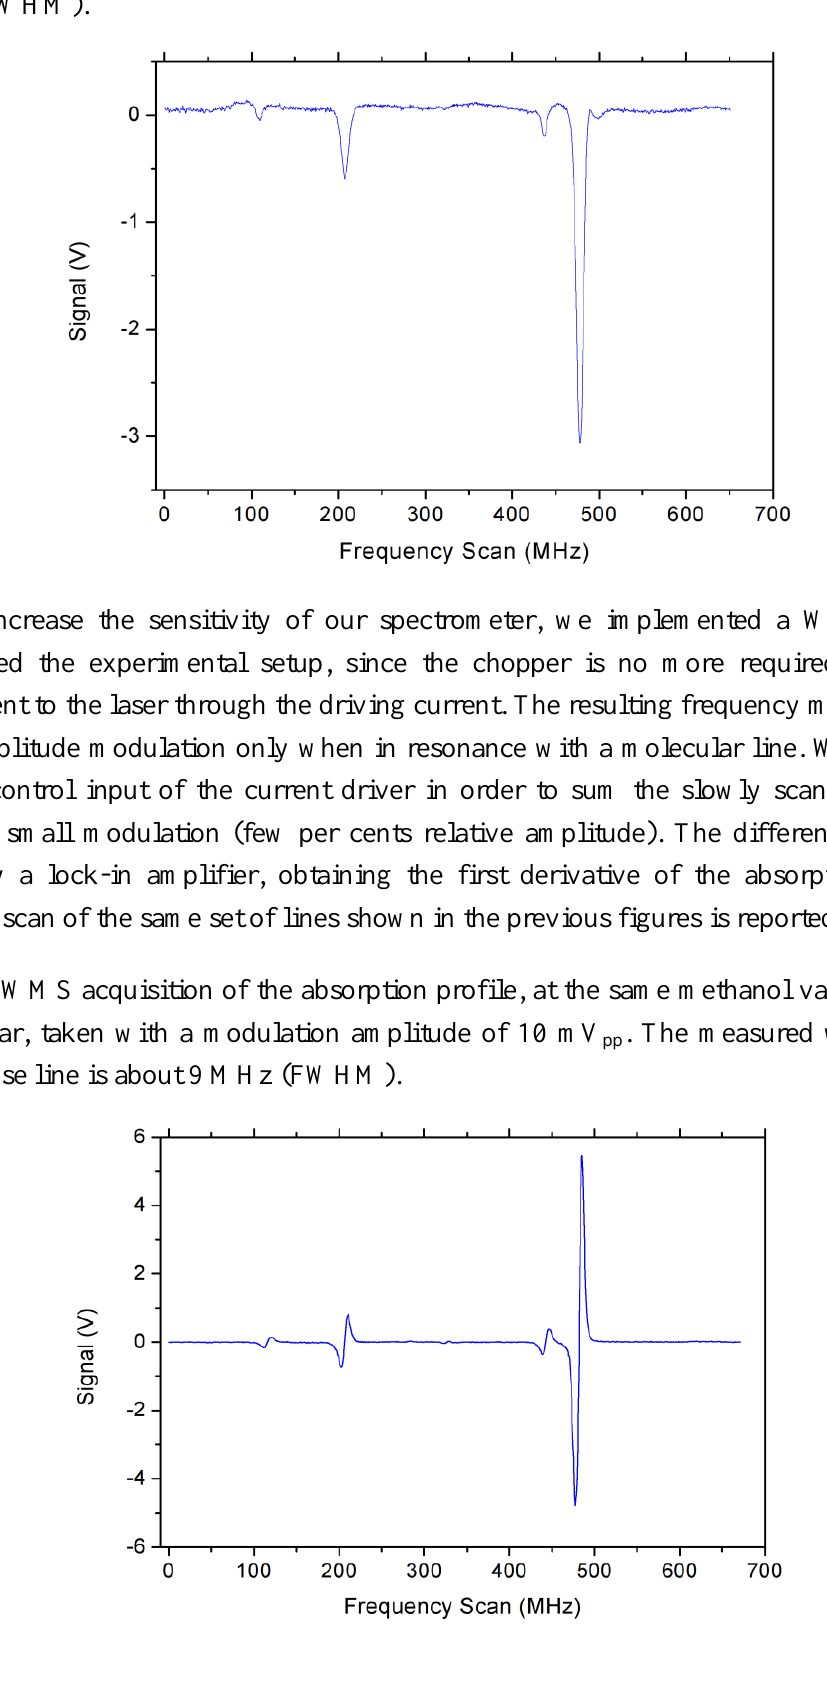
Figure 3. Differential acquisition spectroscopy of the absorption profile. The background slope of Figure 2 is automatically canceled out, since only deviations of the signal from the reference beam are actually detected. The measured width of the most intense line is about 8 MHz (FWHM).